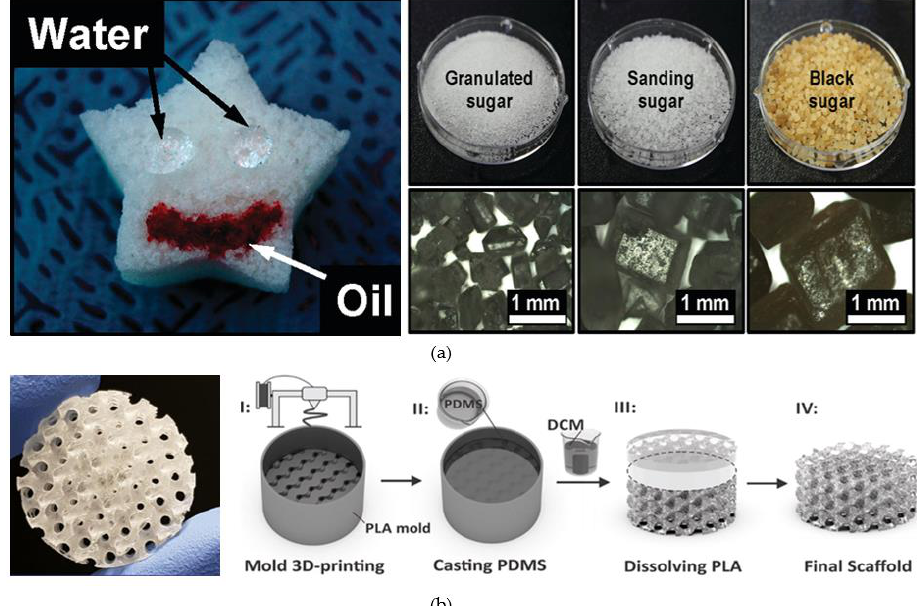
Figure 2. ( a ) Porous PDMS sponges and optical microscope images of various sugar particles; ( b ) Porous PDMS scaffolds and its fabrication process. ( a ) Reproduced with permission. [35] Copyright 2011, ACS Appl Mater Interfaces. ( b ) Reproduced with permission. [36] Copyright 2019, Acta Bio- mater.